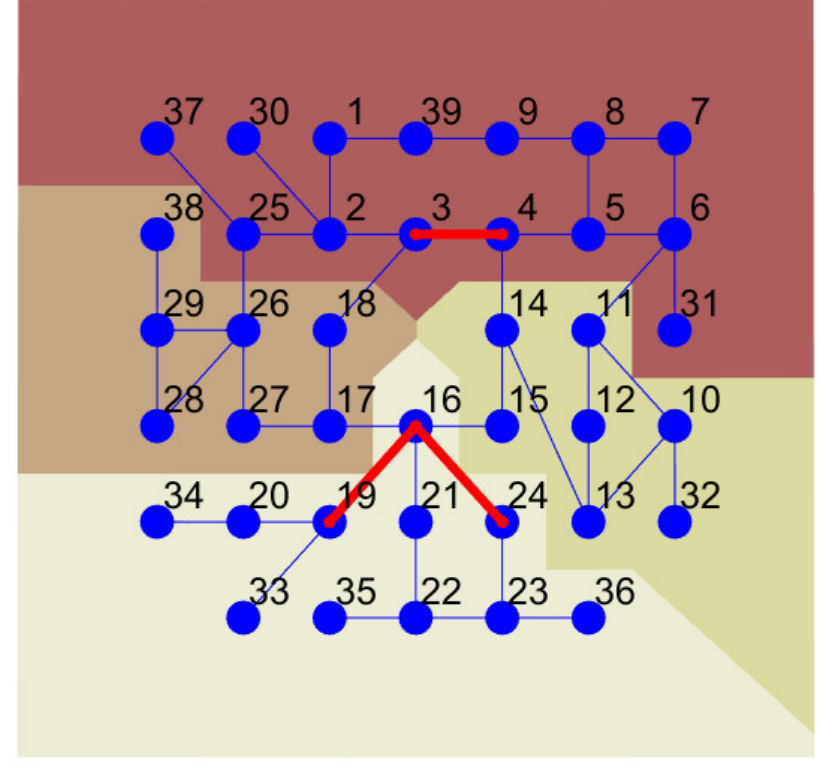
Figure 5. IEEE Case 39 with congested lines marked in